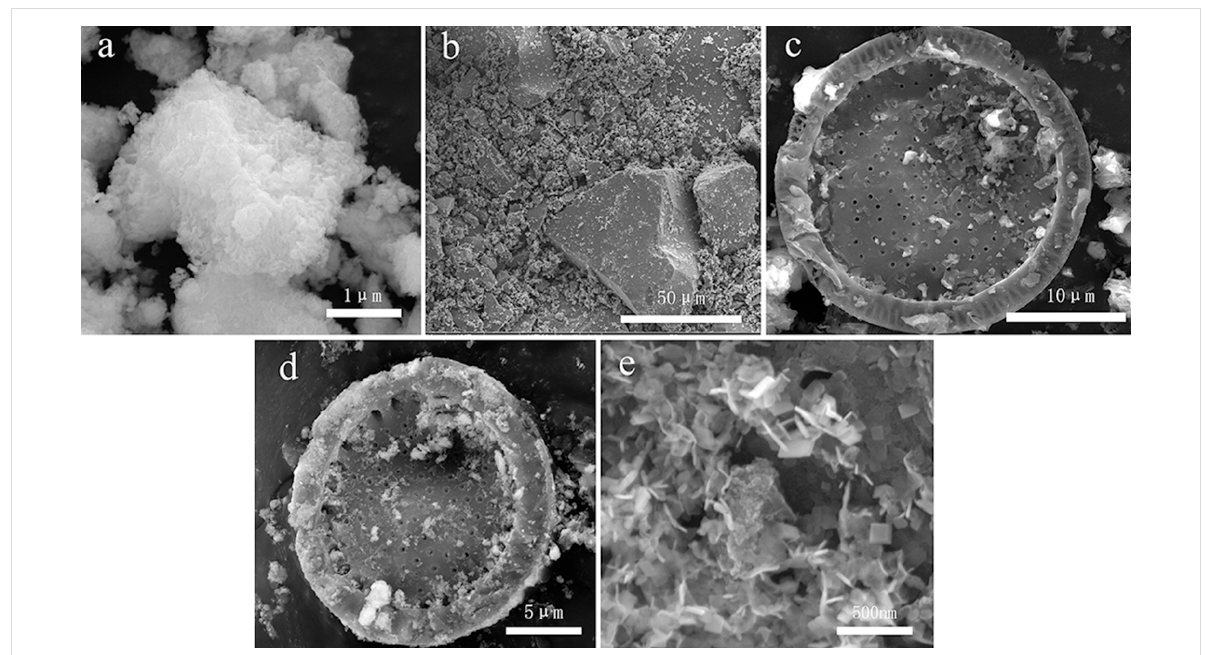
Figure 4: SEM images of BiOCl (a), TiO 2 (b), TiO 2 /diatomite (c) and BTD (d and e).